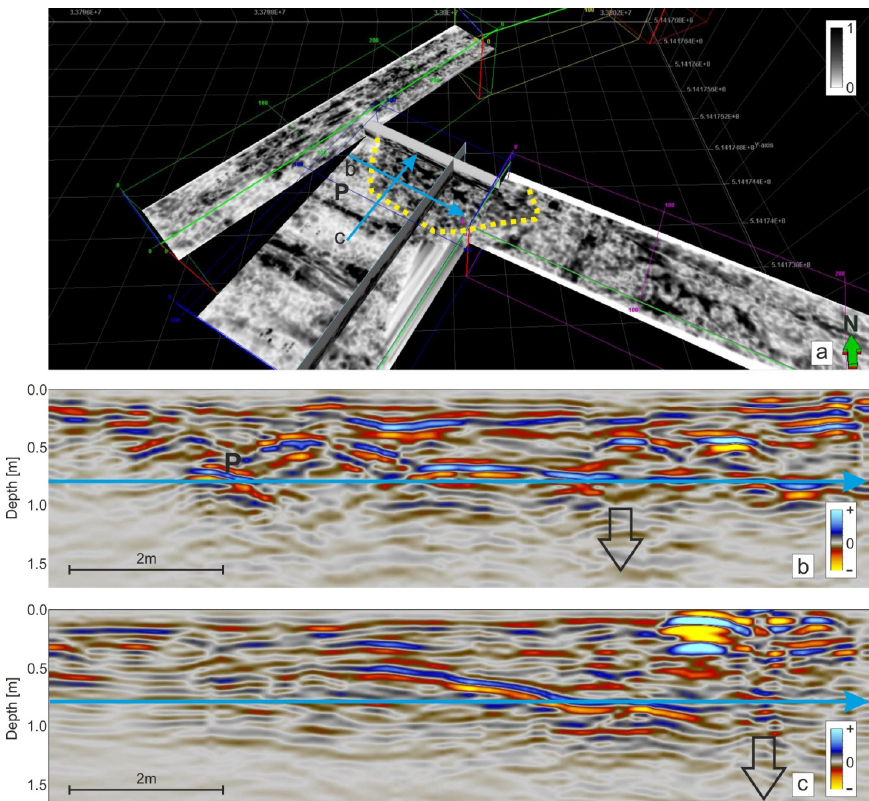
Figure 14. 3D GPR data analysis. ( a ) Perspective view of a portion of the GPR volumes with coherency depth slices at a depth equal to 0.8 m. The dotted yellow line marks the limit of a large depression, which is also imaged by the 2D perpendicular profiles (inline and crossline) in ( b , c ). Light blue lines show the location of shown profiles and the depth slice. The P label marks a clear pipe, while black arrows are located where the deformation reaches the maximum.